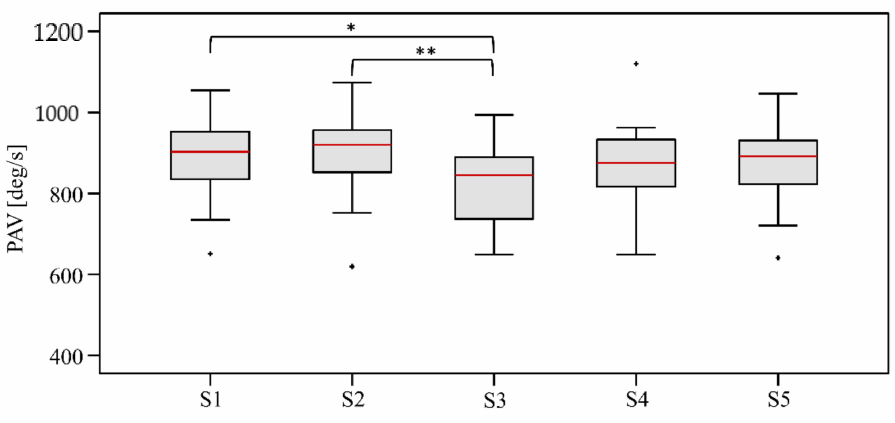
Figure 2. Comparison of peak angular velocity (PAV) between shoe conditions (* p < 0.05; ** p < 0.01). As shown in the example for one subject in Figure 3, the lowest PAV was found in S3.